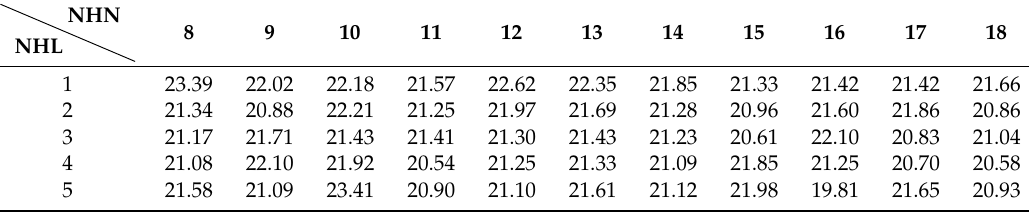
Table 5. The coefficient of variation of the root mean squared error (cvRMSE) (%) according to the number of hidden neurons and layers.